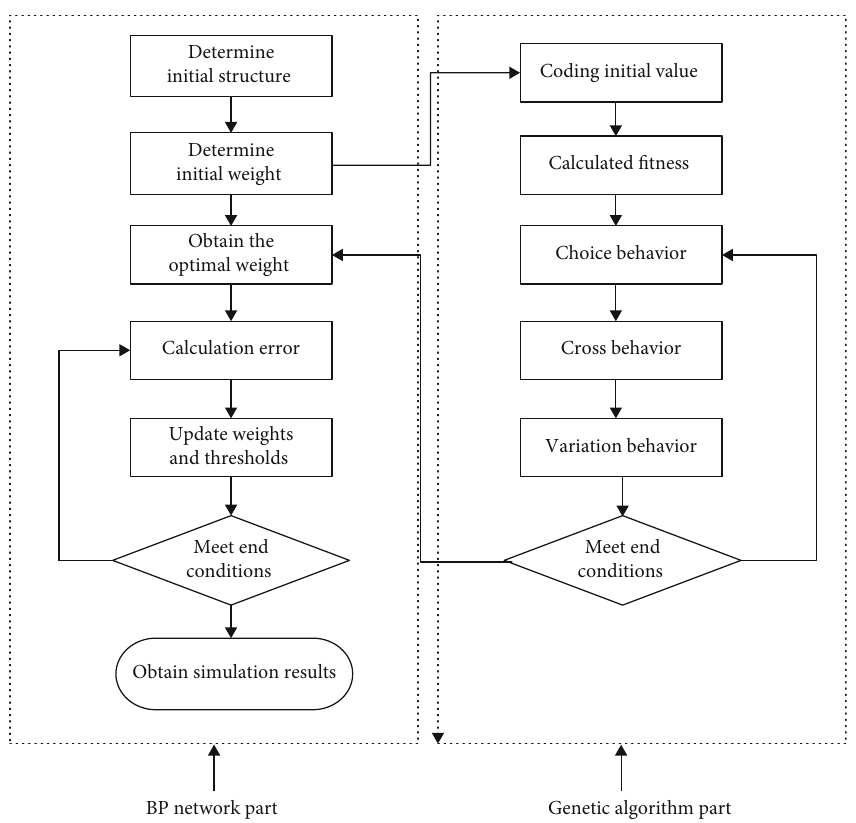
Figure 2: Optimization of weight fl ow of BP network by genetic algorithm. Table 1: Characteristic variables a ff ecting house price and variables ’ input